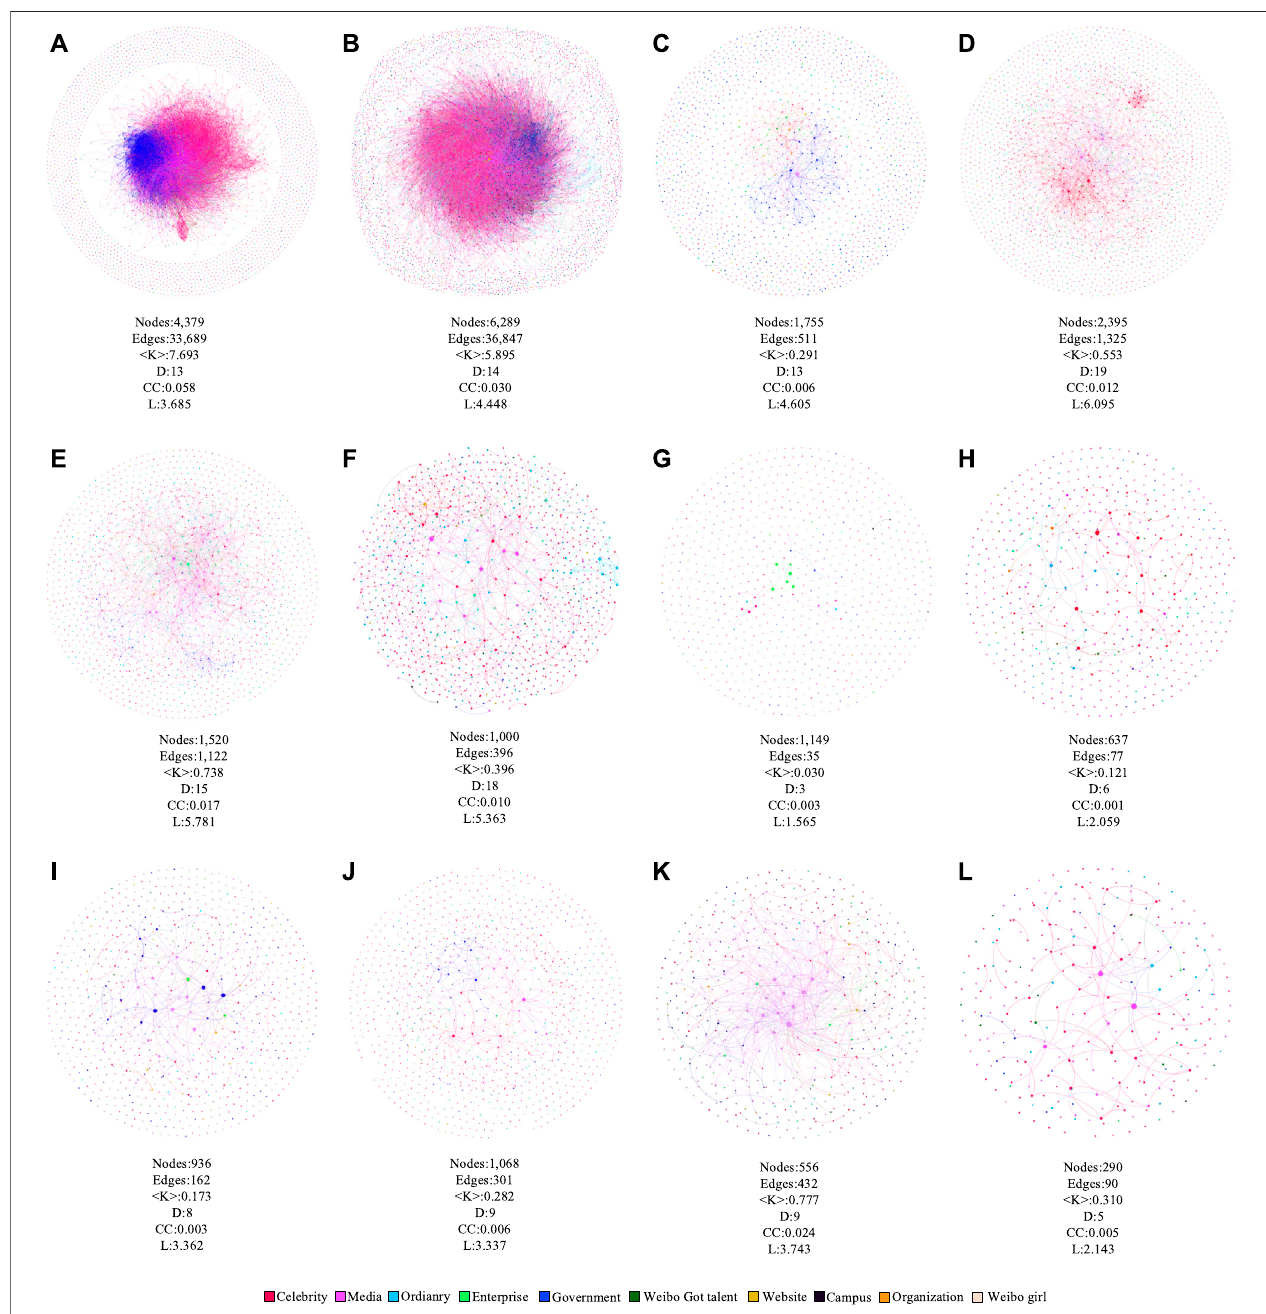
FIGURE5| SRNsundersixtypesoffakenews: (A) ofrefuters(R – R)insociety-relatedfakenews, (B) ofnon-refuters(NR – NR)insociety-relatedfakenews, (C) R – R in health-related fake news, (D) NR – NR in health-related fake news, (E) R – R in business-related fake news, (F) NR – NR in business-related fake news, (G) R – R in science-related fake news, (H) NR – NR in science-related fake news, (I) R – R in disaster-related fake news, (J) NR – NR in disaster-related fake news, (K) R – R in politics- related fake news, and (L) NR – NR in politics-related fake news.